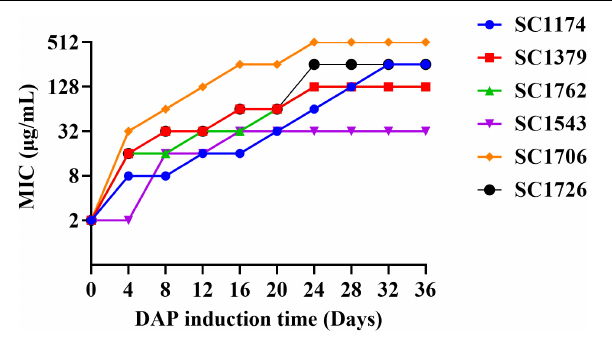
FIGURE 1 | Enterococcus faecium adapts to daptomycin. The in vitro evolution of reduced daptomycin (DAP) susceptibility in evolved DAP-resistant (DAP-R) E. faecium through serial passages in increasing concentrations of DAP for a period of 36 days.